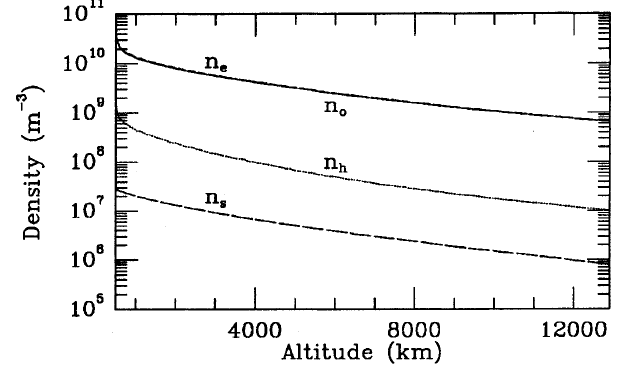
Fig. 1. Electric potential profile calculated by the self-consistent hybrid model. The magnitude of the potential drop is comparable to value deduced from observations